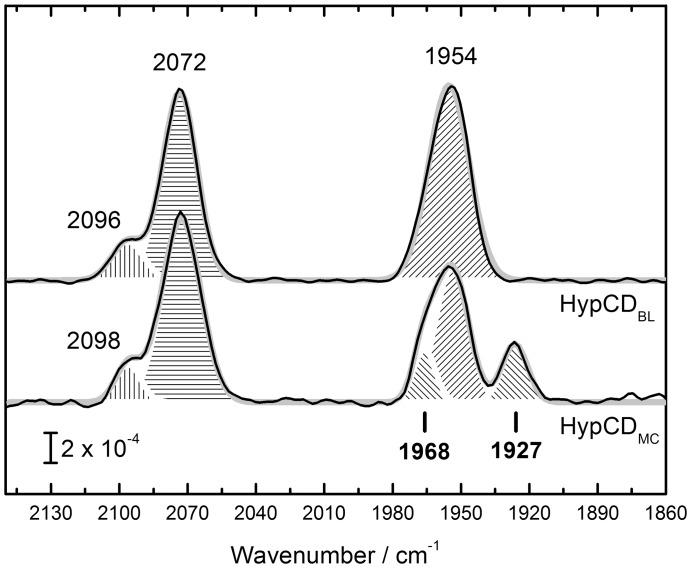
Comparison of the IR spectra of HypCD from E. coli strains BL21(DE3) and MC 4100.HypCDBL shows the characteristic signature [17], [18] of one CO (1954 cm−1, diagonal hatch) and two CN− ligands (2072, 2096 cm−1, straight hatch). HypCDMC has a novel contribution in the CO region (1927 cm−1) and shows a shoulder blue–shifted to the CO peak at 1954 cm−1. The latter shoulder fits best to a Gaussian peak with a center wavenumber of 1968 cm−1. The bold gray line in the background represents an overall fit of the spectrum.